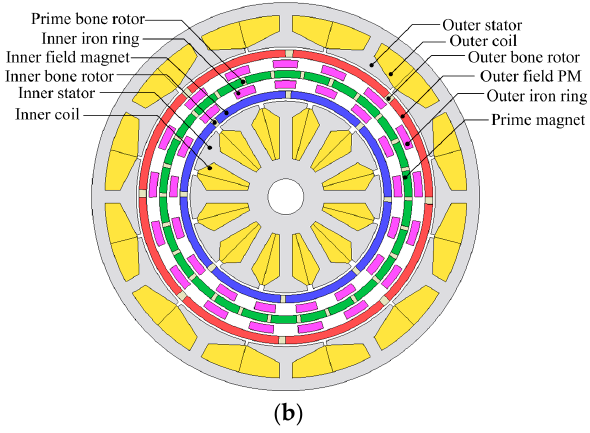
Figure 1. Proposed structure of double-stator permanent magnet machine integrated with a triple rotor magnetic gear: ( a ) Exploded view of machine components; ( b ) Structural view of integrated machine. Table 1. Design parameters of double-stator magnetic geared machine.